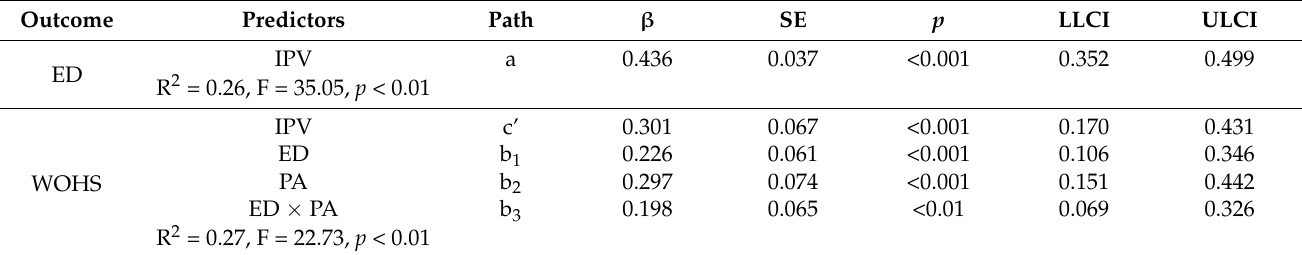
Figure 2. The coefficient estimates and statistical significance of the moderated-mediation model. Table 3. Ordinary least squares regression results for moderated effect. Table 3. Ordinary least squares regression results for moderated effect.